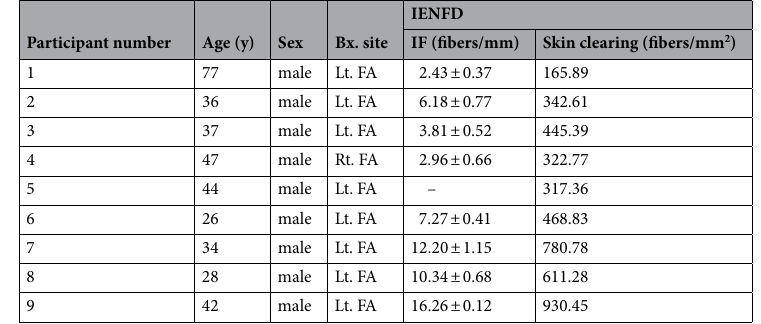
Table 1. Demographics and quantified intraepidermal nerve fiber densities (IENFDs) of the participants. Bx . Biopsy, FA Forearm, IF Immunofluorescence.